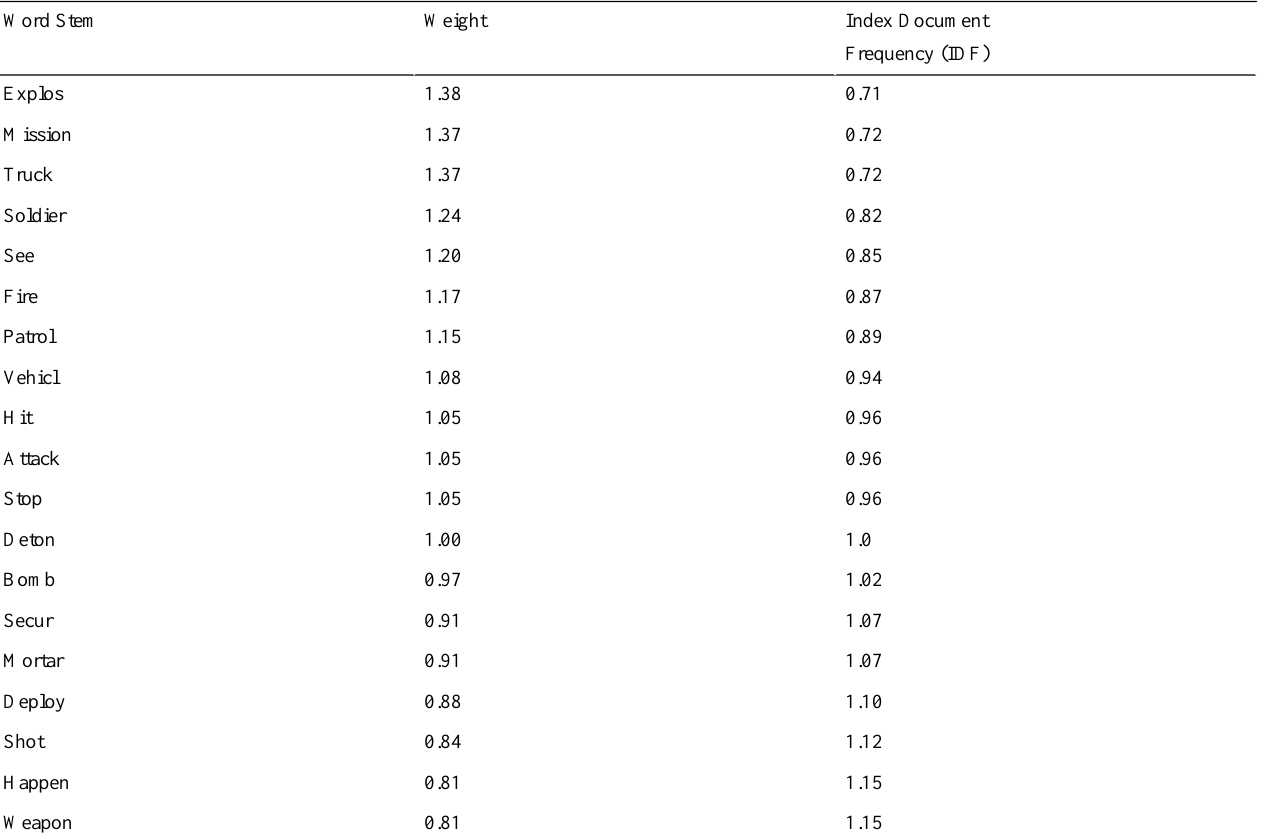
Table 1. Most frequent word stems related to combat